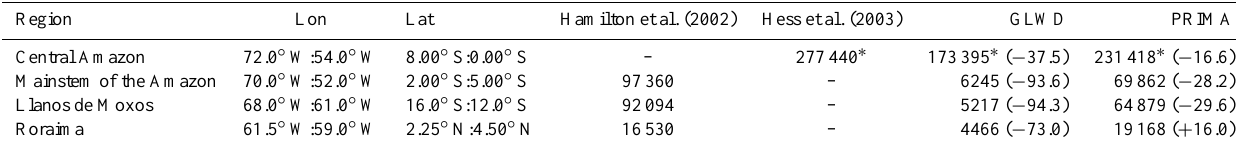
Table 4. Maximal areas in floodplains (km 2 ) from satellite estimates (Hamilton et al., 2002; Hess et al., 2003) and the two datasets GLWD and PRIMA. Number in brackets is the relative error (in %) between the datasets and the estimates.